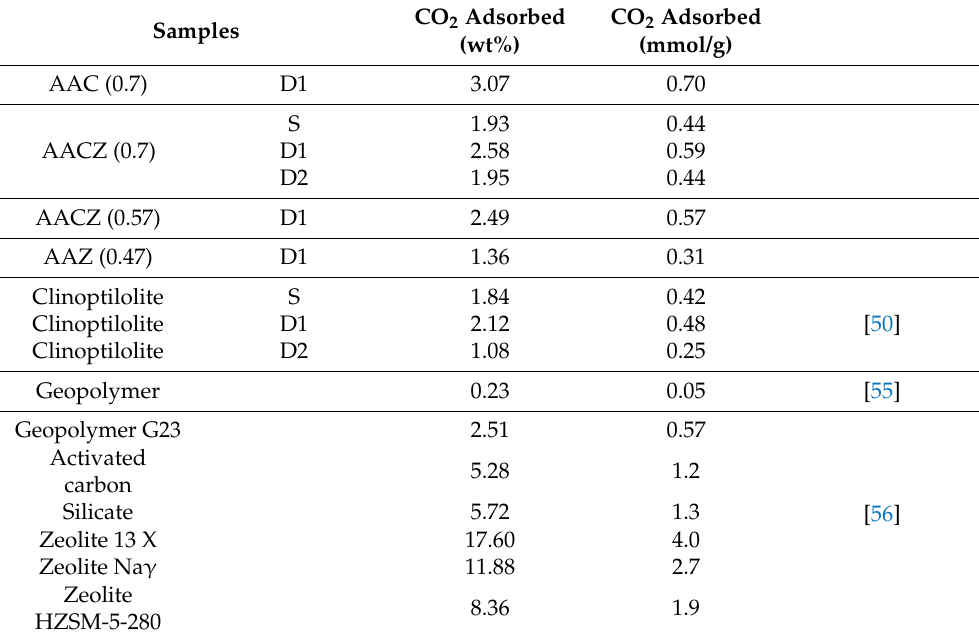
Table 5. Adsorbed CO 2 (wt%; mmol/g) of prepared samples determined by TGA and comparison with samples from other